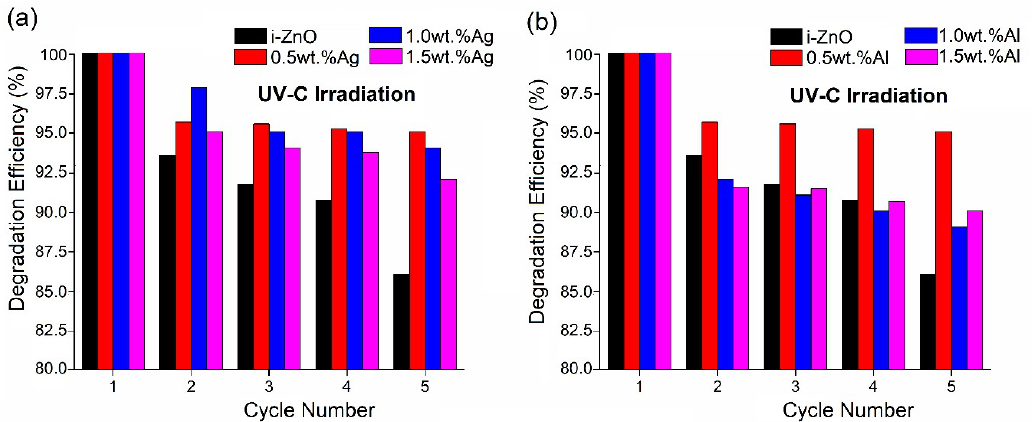
Figure 9. Comparison of photostability of i ‐ZnO and doped ZnO films after five runs in MB solution under UV‐C irradiation: ( a ) ZnO:Ag and ( b ) ZnO:Al.